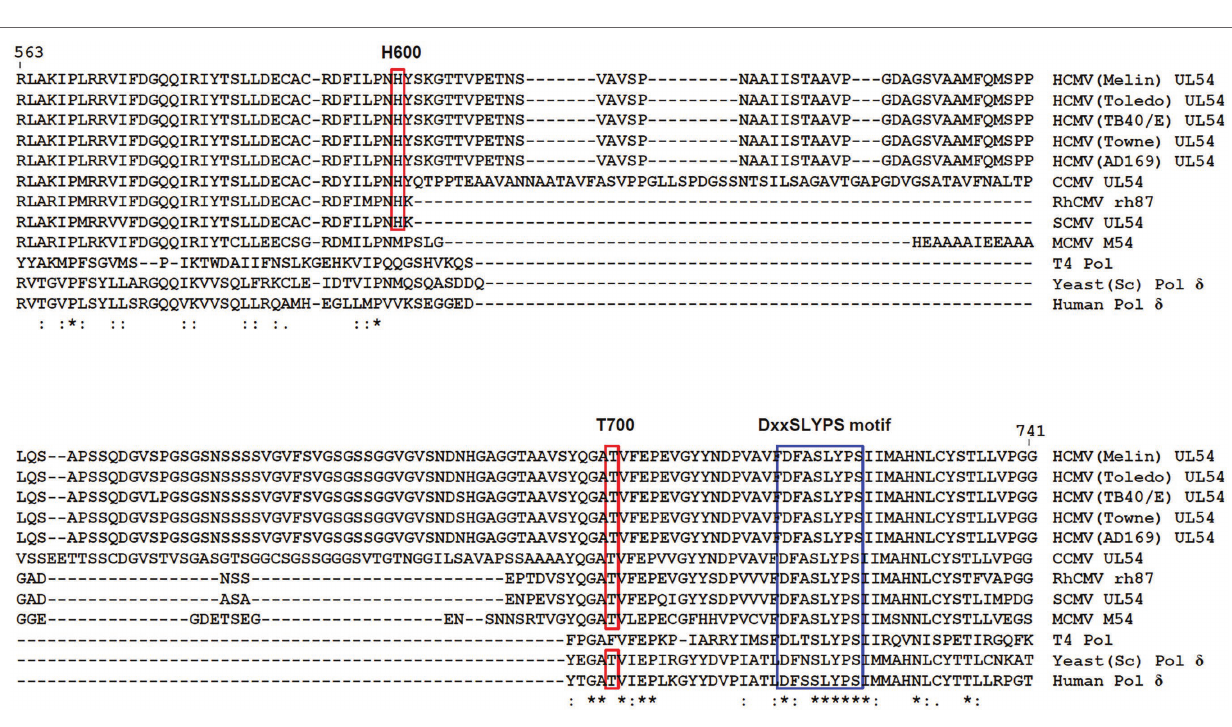
FIGURE 5 | H600 and T700 amino acid positions in the palm loop of viral DNA polymerases. Amino acid sequences including H600 and T700 of HCMV (Toledo) UL54 are aligned with other sequences from other CMV polymerases, T4 polymerase, yeast polymerase δ , and human polymerase δ using CLUSTALW. Residue numbers in HCMV (Toledo) UL54 are shown. Identical (*), strongly similar (:), and weakly similar (.) sequences are indicated. The amino acid positions for H600 and T700 in HCMV (Toledo) UL54 and the corresponding conserved residues in other CMV polymerases and for the highly conserved DxxSLYPS motif are boxed. Accession numbers for CMV DNA polymerases are as follows: AAR316191, HCMV (Merlin) UL54; ADD391151, HCMV (Toledo) UL54; AGQ472841, HCMV (TB40/E) UL54; ACM480431, HCMV (Towne) UL54; ACL511341, HCMV (AD169) UL54; NP_6126981, CCMV UL54; YP_0681801, RhCMV rh87;